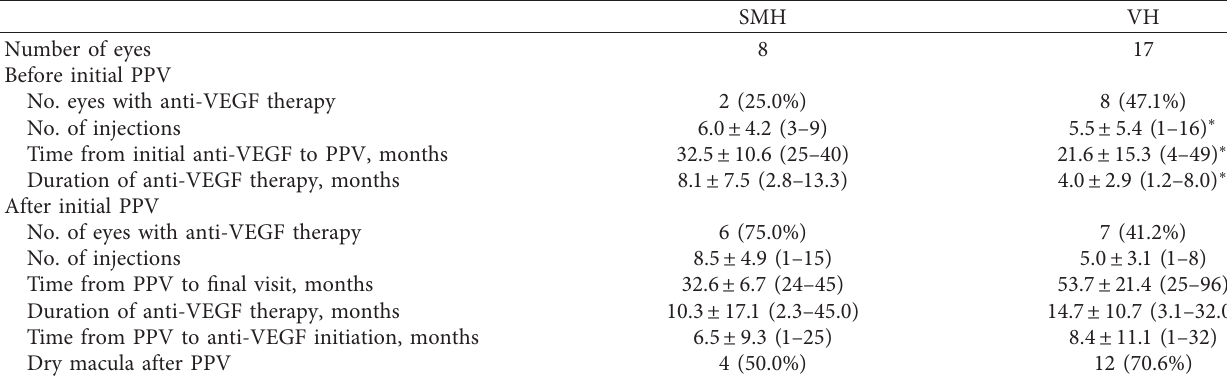
Table 3: Anti-VEGF therapy before and after PPV.